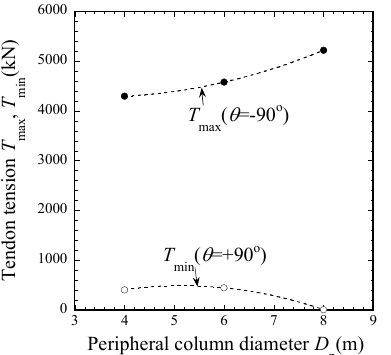
Fig. 9 Tendon tension dependency on H p ( L : D p = 30 m: 6 m, T 0 = 2290 kN, under storm conditions).